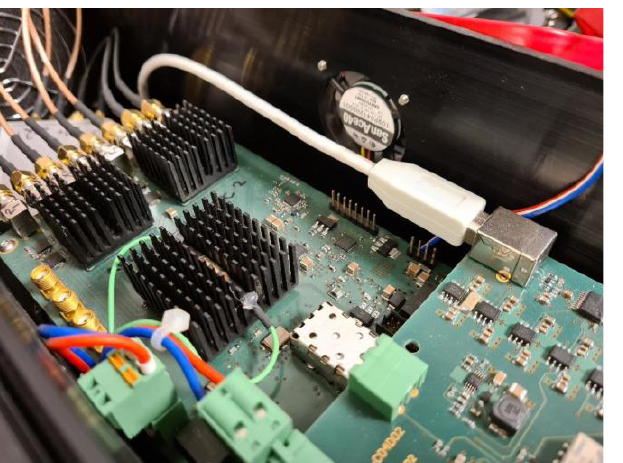
Fig. 5 Digitization card FD-17 with the FPGA (Virtex 6) and two ADC converters with a resolution of 12 bits and a sampling frequency of 500 MS/s containing four differential pair inputs and Ethernet output